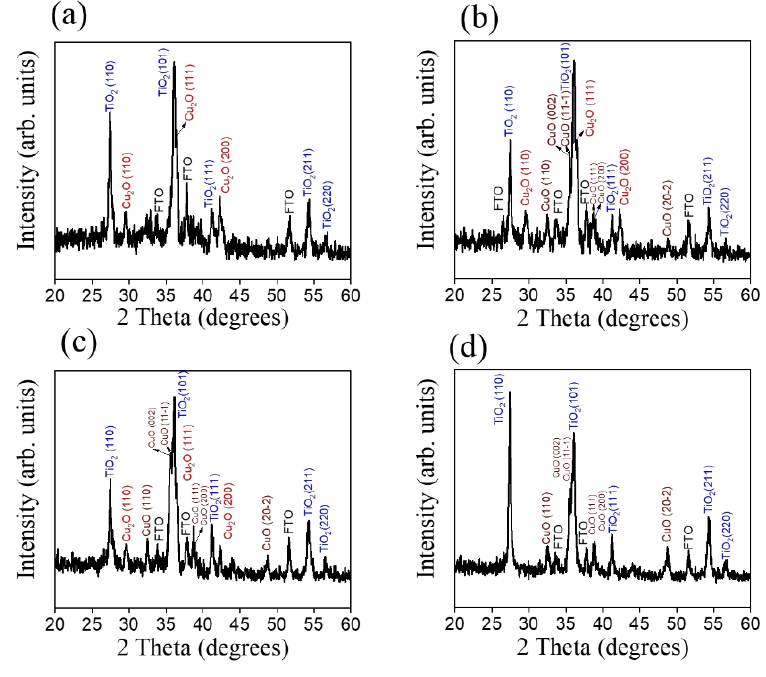
Figure 2. XRD patterns: ( a ) TC200, ( b ) TC300, ( c ) TC350, and ( d ) TC400.